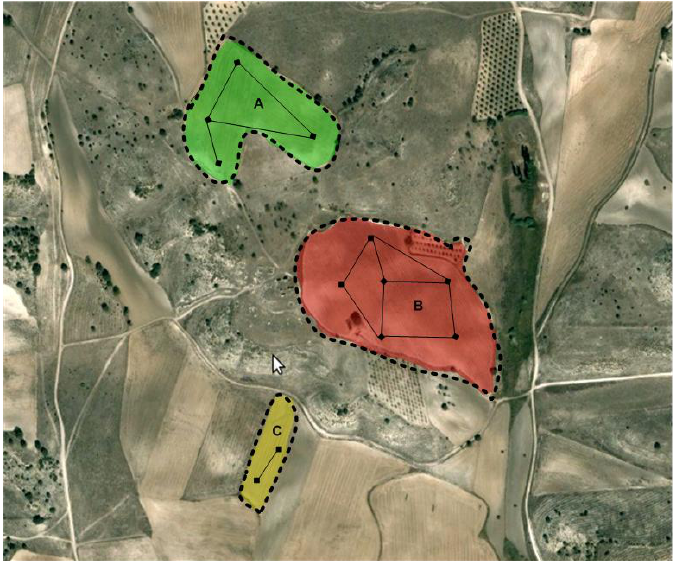
Figure 12. The three parcels adopted for the experimental scenario with the corresponding WSN